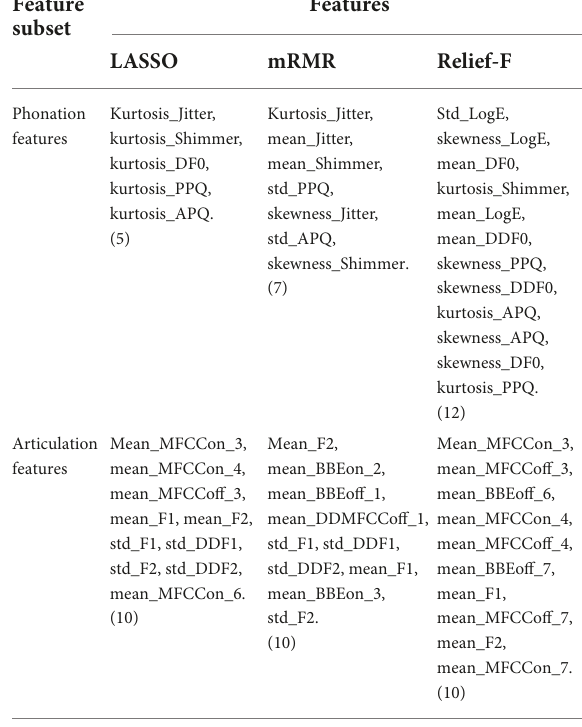
TABLE 2 Features obtained by using three features selection algorithms (std stands for standard